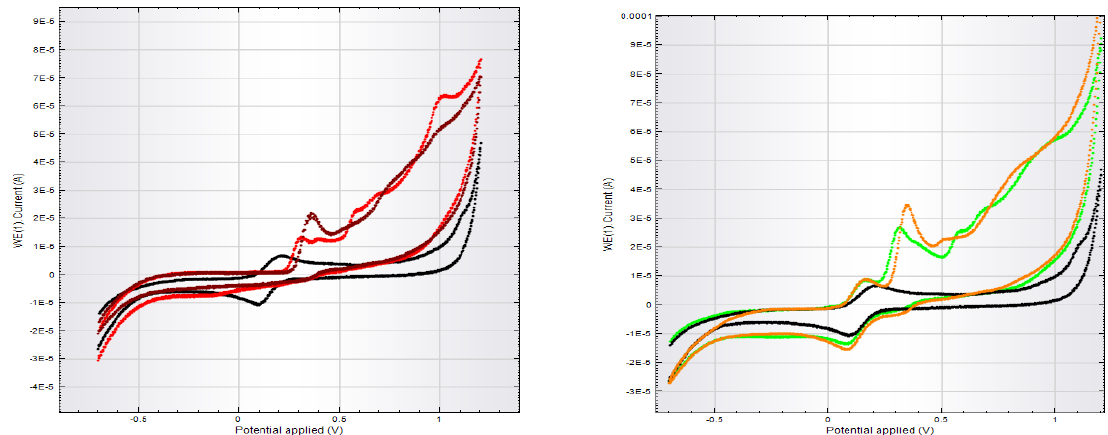
Figure A2. Left —Comparison between CVs for 0.5 mM of potassium ferricyanide (black), 5a (red) and 5b (brown). Right — Comparison between CVs for 0.5 mM of potassium ferricyanide (black); mixtures of 0.5 mM of potassium ferricyanide and 0.5 mM of 5a (light green) and 5b (orange).